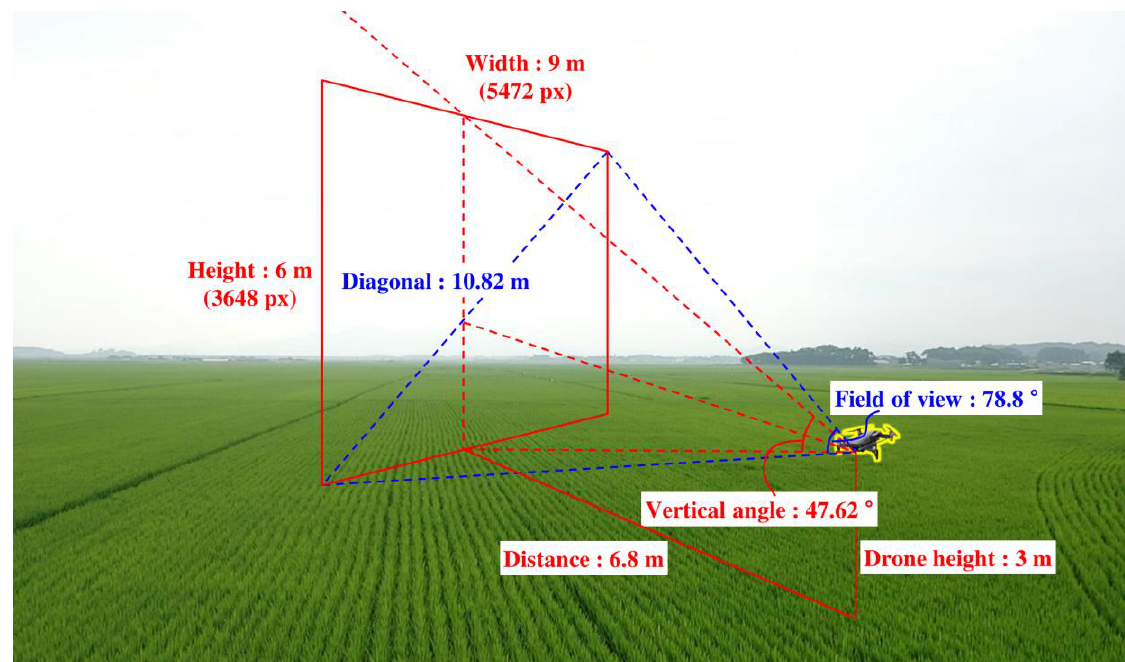
Figure 11. Calculation of the camera field of view for the operating drone.